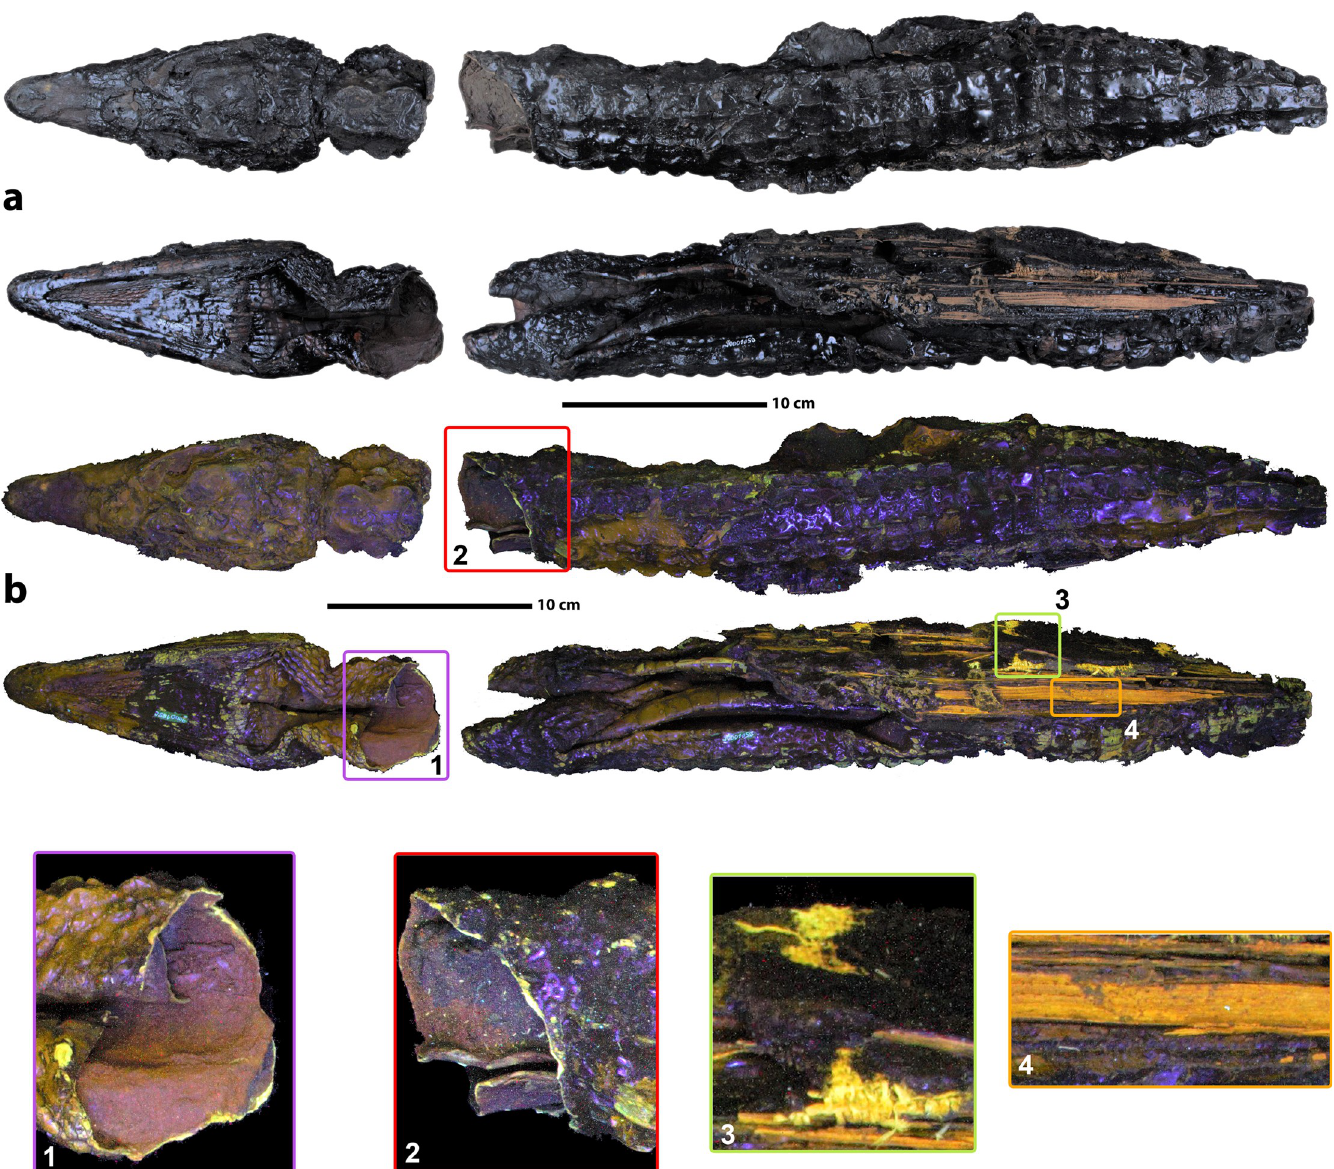
Fig 1. Crocodile mummy MHNL 90001850. a. Visible light picture of the specimen, b. UV fluorescence picture of the specimen showing in brown and dark green the parts of skin without balm, in light green the exposed skin where the body and the head are separated [1, 2], in light green the exposed osteoderms and eggshell fragments, in orange the palm-tree wood [4] and in yellow several remaining parts of the original textiles [3]. The violet parts are reflections of the lamp on shiny dark surfaces of balm.